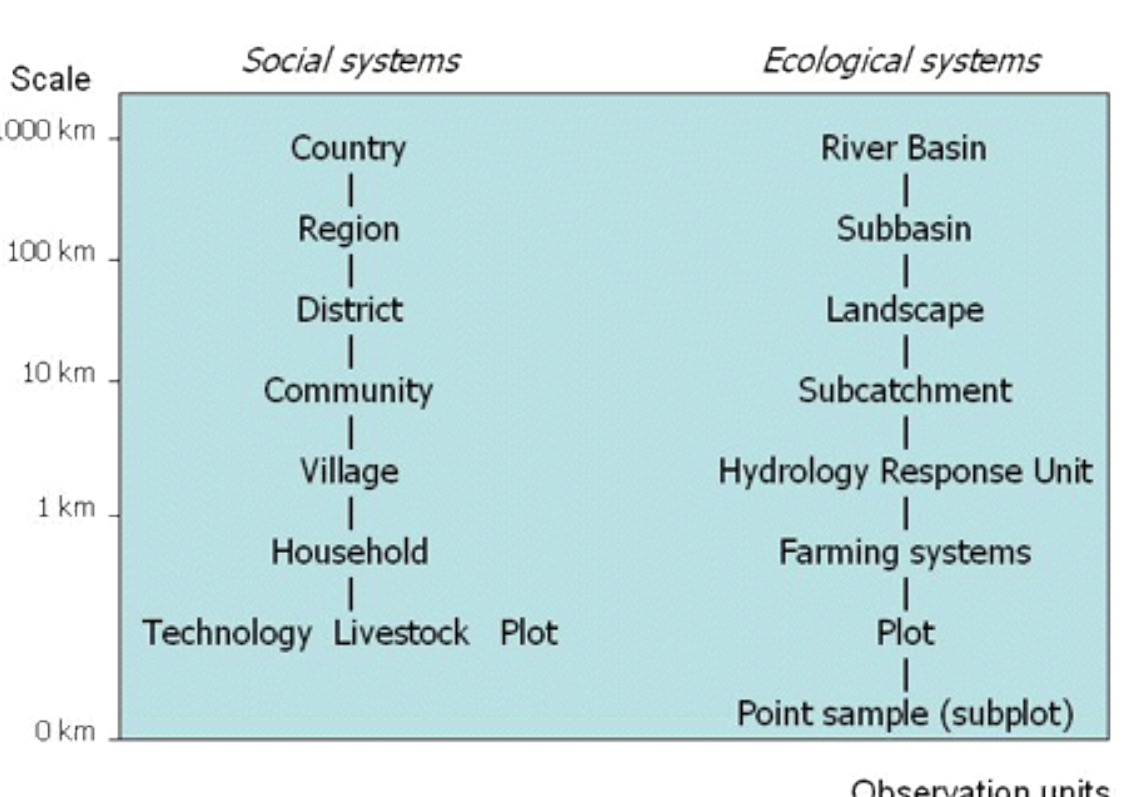
Fig. 1. Hierarchy of observation units in interdisciplinary